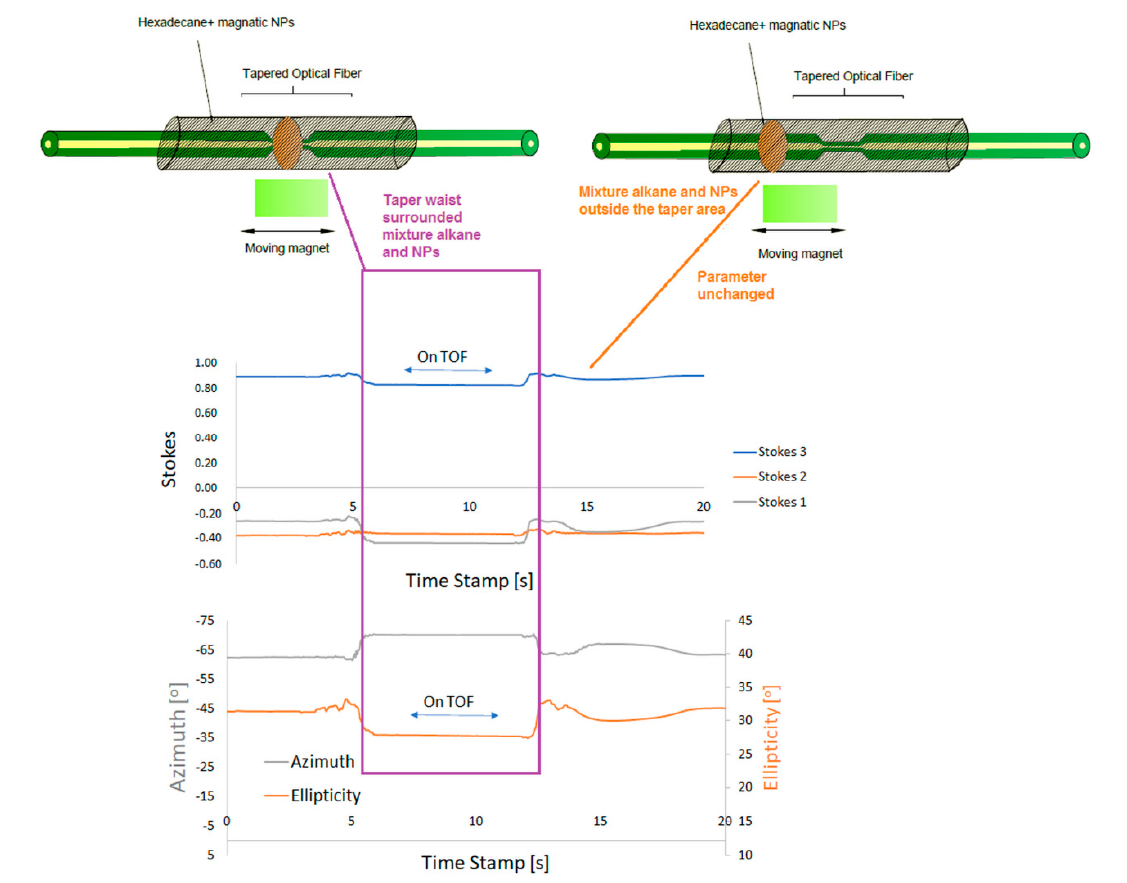
Figure 13. Scheme, idea, and results of the proposed measurement of the magnetic sensor.